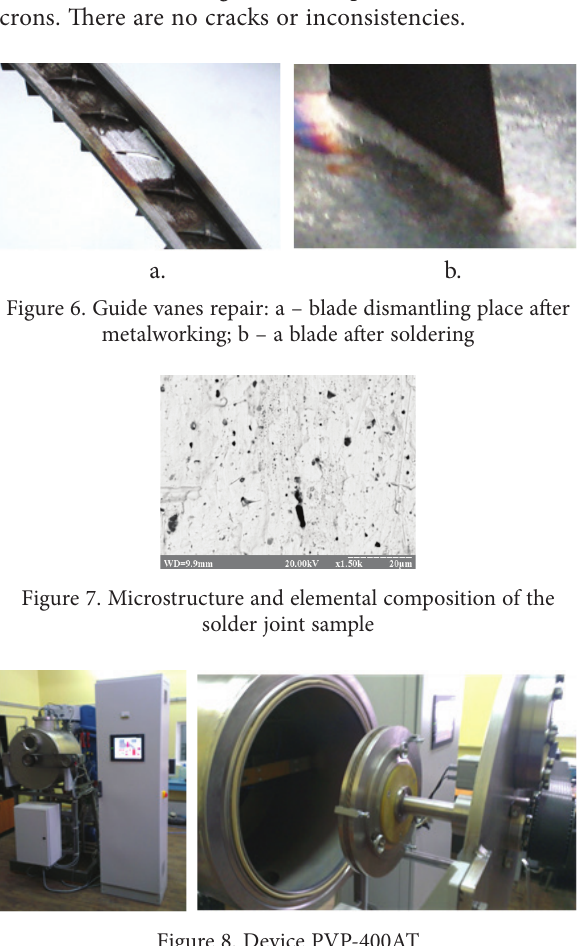
Figure 8. Device